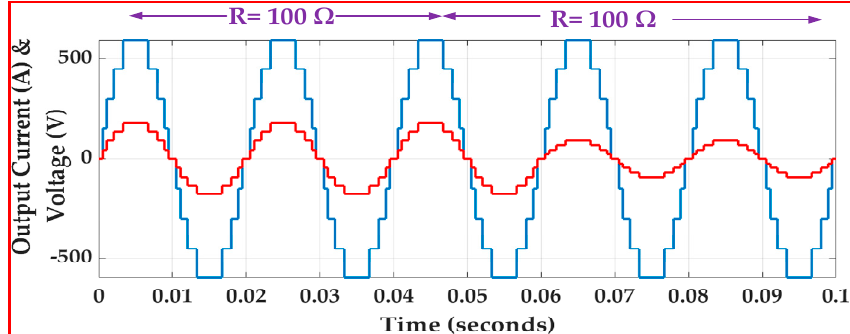
Figure 9. Dynamic resistive load change.